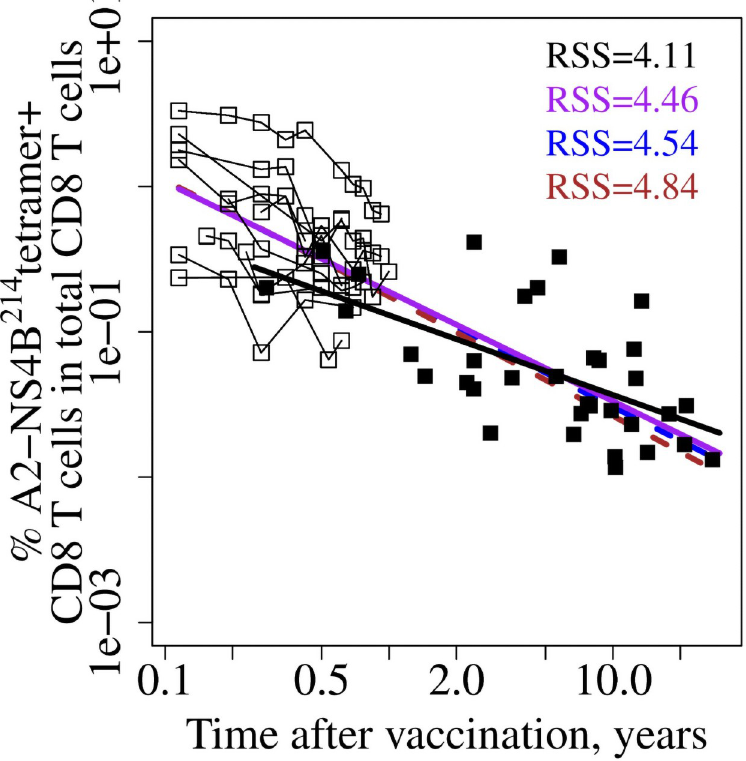
Fig 5. Predictions for Marraco’s data from Model 4 (blue line), Model 5 (brown line), and the simple power law model (purple line). Data from the Akondy study [24] and the Marraco study [14] are shown as open and closed squares, respectively. Data points for each individual donor in the Akondy study are connected by a thin black line. For Models 4 and 5, we fit the models to the Akondy data (Fig 1) from day 42 to 1 year using a mixed-effect framework to estimate the population parameters and based on these population parameters predict the frequency of YFV-specific cells up to 30 years after vaccination. We compare models predictions with the Marraco data using RSSs (RSS value colors matched the corresponding lines). Unlike Models 4 and 5, the simple power law model uses only YFV-specific T cells data (Fig 1A) and no DNA enrichment data. Use of a mixed-effect framework is essential for accurate prediction for all three models. Additionally, a power law fit for Marraco’s data only is shown with a black